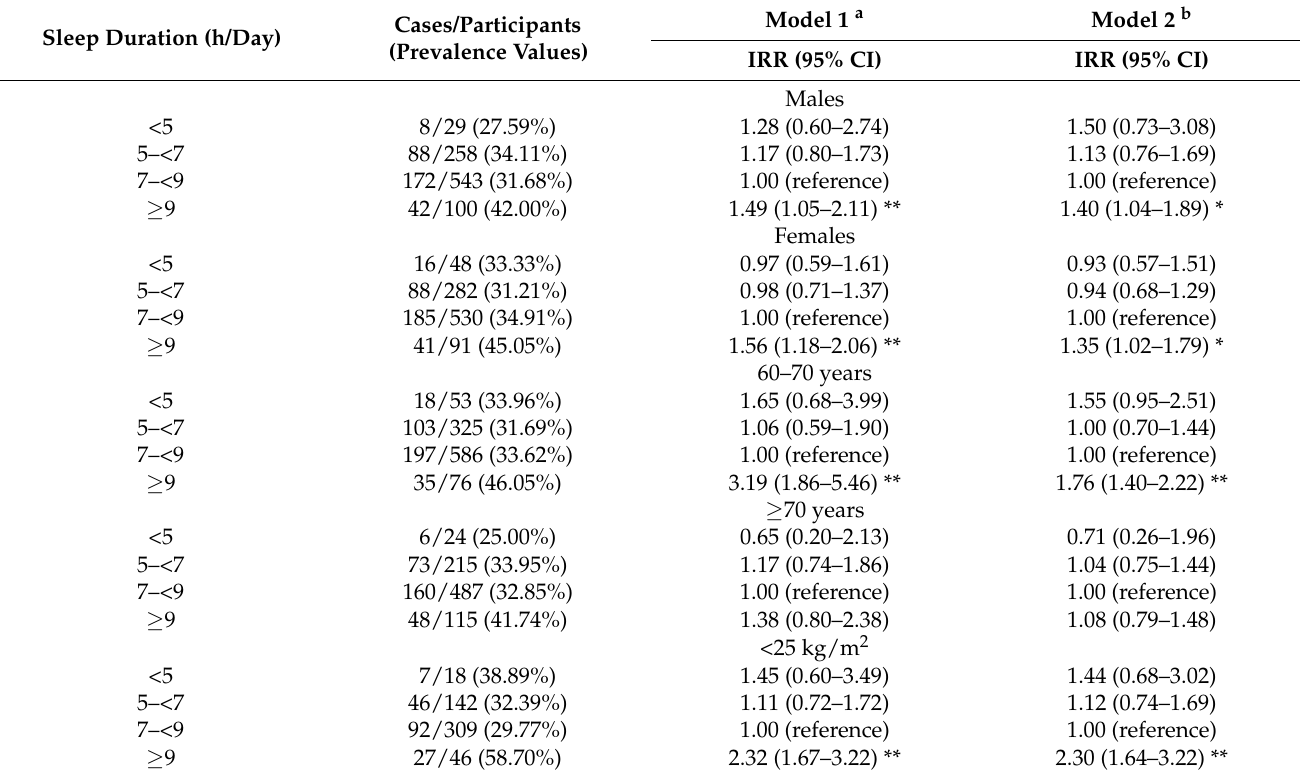
Table 3. Weighted IRRs and 95% CIs of low grip strength according to sleep duration stratified by gender age and BMI, NHANES